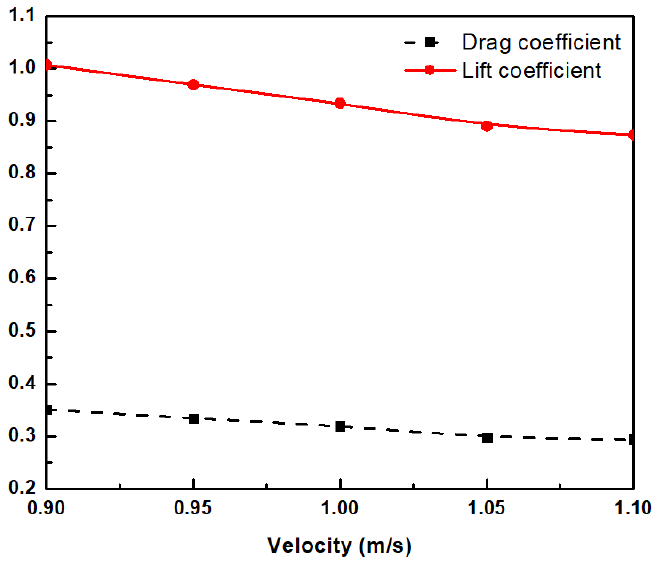
Figure 8. Drag and lift coefficients curves for the underwater glider with the angle of attack θ = −10 ° at the different velocities. Table 3. Data obtained from the computation by using CFD for the different velocities of the glider. Velocity (m/s) Drag Force (N)